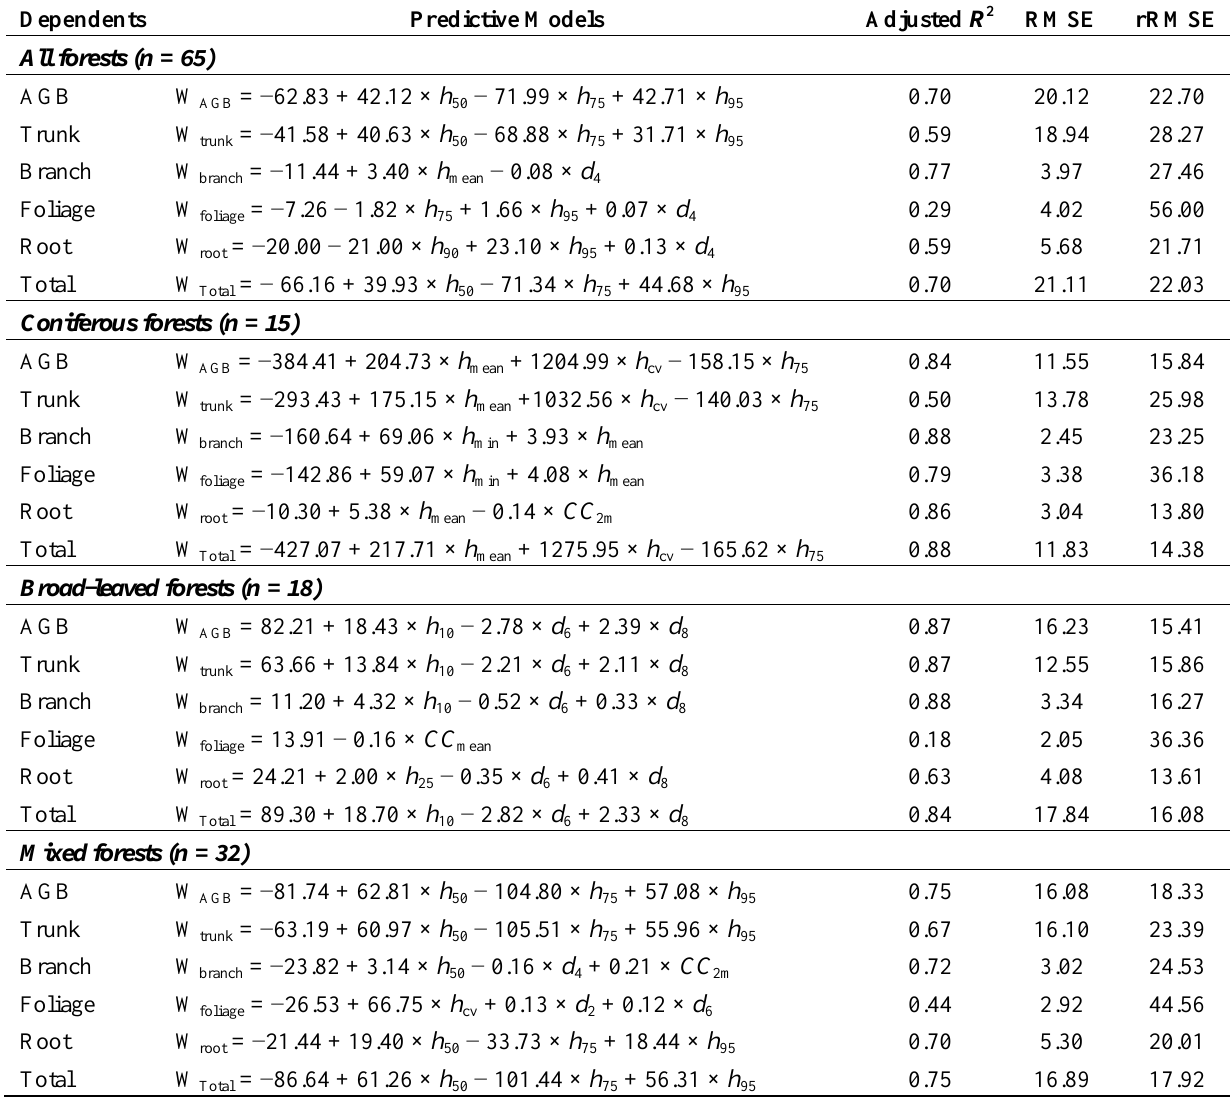
Table A1. Predictive models and accuracy assessment results (by discrete LiDAR